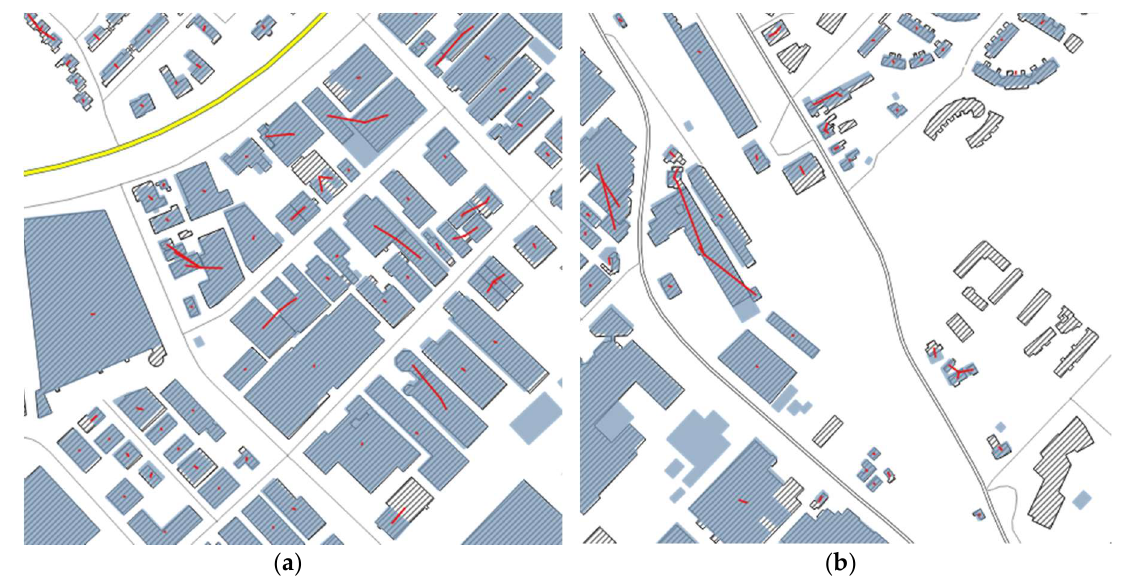
Figure 2. Identified corresponding buildings in OSM (filled with hash lines) and TOP10NL (blue) in ( a ) industrial area and ( b ) its outskirt: 1-to-1 and m -to- n relations are visualized by red links, and 1- to-0 and 0-to-1 relations are those without a